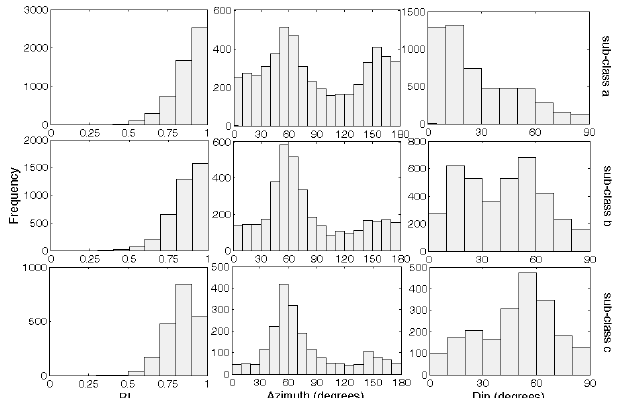
Fig. 7. (a–c) Distributions of the maxima of the cross-correlation function estimated by adopting a master TE of sub-class a, b, c, respectively. (d–e) Distributions of the maxima of the cross- correlation function estimated adopting a master TE of class A and B, respectively.